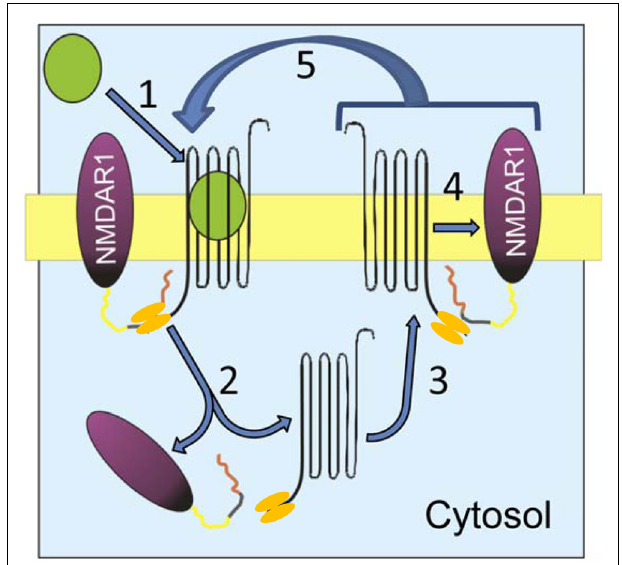
FIGURE 2 | Proposed mechanism of cannabinoid-induced NMDAR hypofunction. CB1 and the NMDAR NR1 subunit associate in the post-synapse via the homodimeric HINT1 protein. (1)The agonist binds to CB1 and (2) promotes co-internalization of CB1–HINT1 and NR1 subunits. These proteins separate in the cytosol and (3) CB1–HINT1 returns to the plasma membrane. (4)The re-sensitized CB1 associates with new NR1 subunits and (5) the cycle is reinitiated while the agonist remains in the receptor environment.